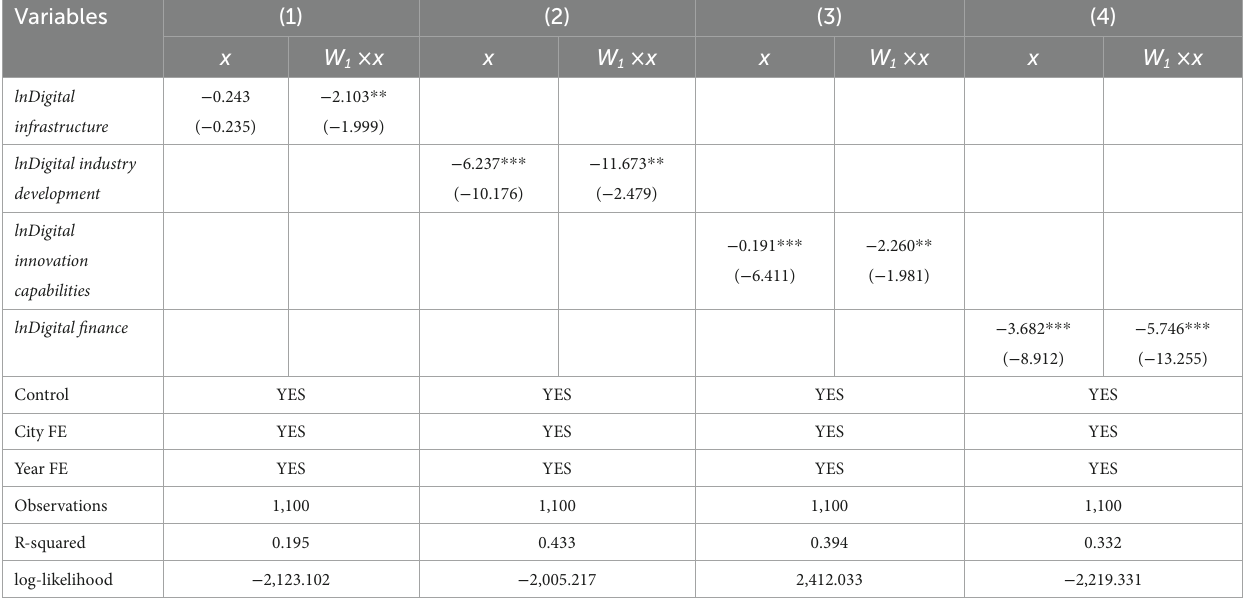
TABLE 10 Decomposition of the role of the digital economy on